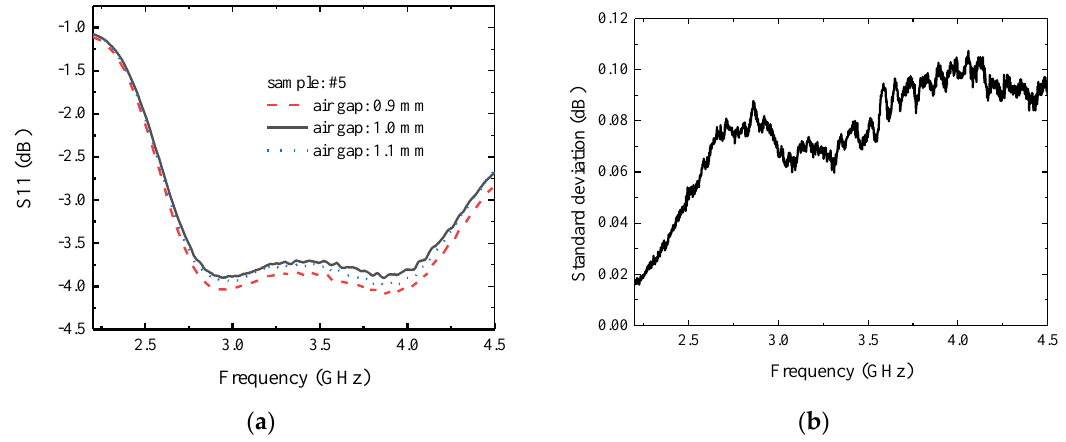
Figure 6. Measured effect of air gap: ( a ) S 11 vs. frequency; ( b ) standard deviation of S 11 .